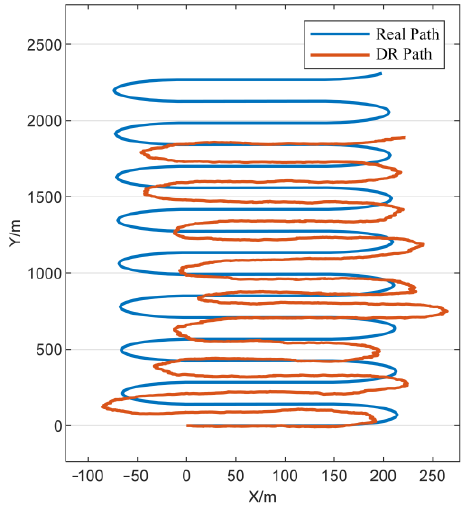
Figure 16. Paths of master and slave AUVs based on DR.